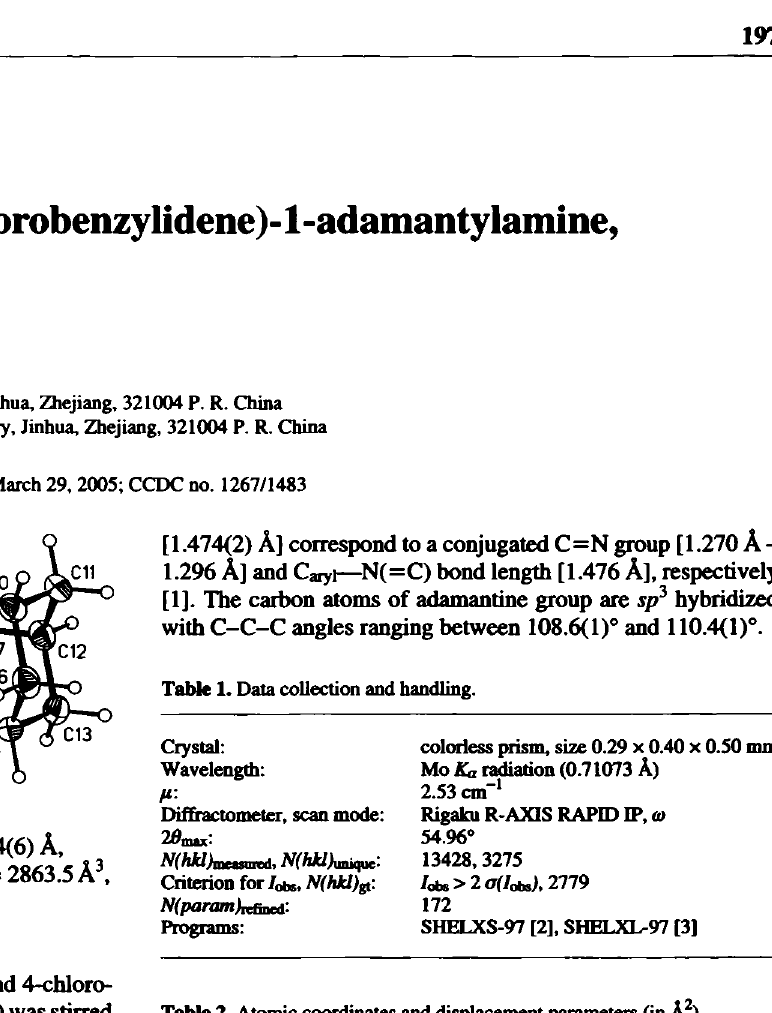
Table 2. Atomic coordinates and displacement parameters (in A 2 ).